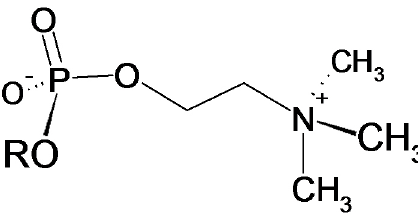
Figure 1. Structure of the phosphocholine functionality with R being an N -glycan or the sidechaine of an amino acid.